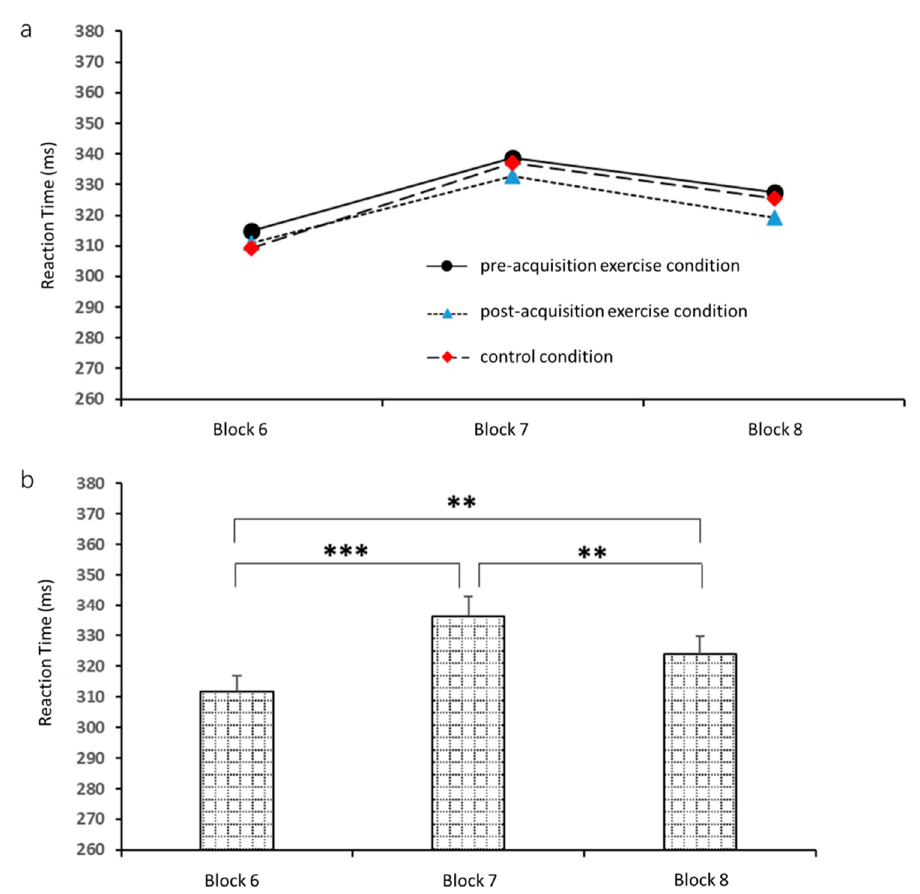
Figure 7. Mean reaction times in the 1-h sequence test by block and by exercise condition. ( a ) Comparison of reaction times among blocks 6, 7, and 8. ( b ) Comparison of reaction times among pre-